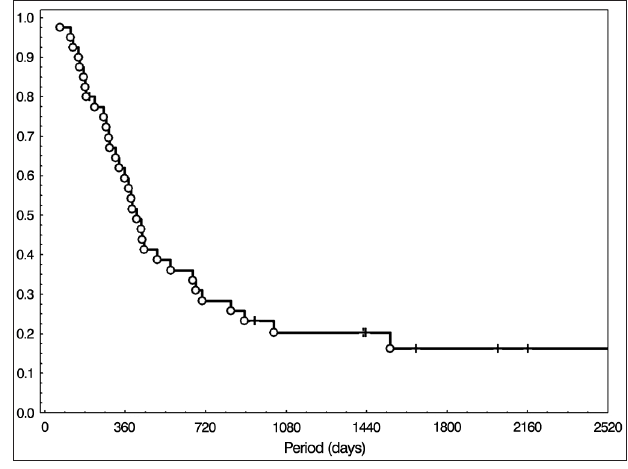
Figure 4. Overall survival in the group treated with radiotherapy and